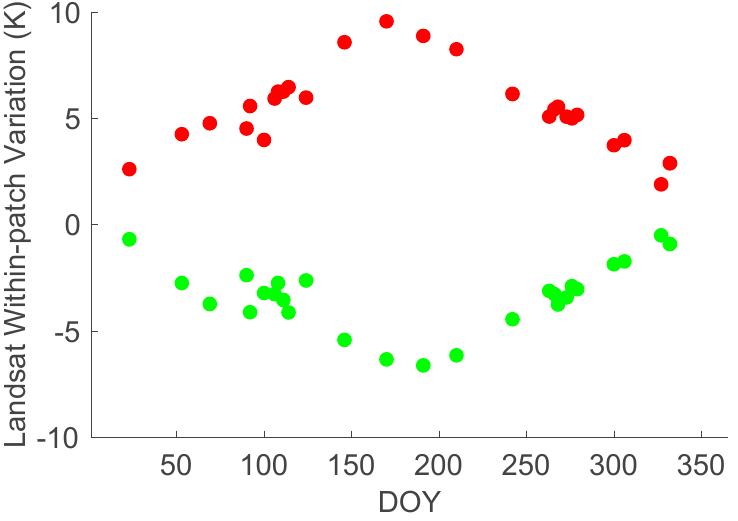
Figure 7. Seasonal change of Landsat within-patch variations (pixel LST minus patch mean LST). Red dots: urban pixel; green dots: rural pixel.